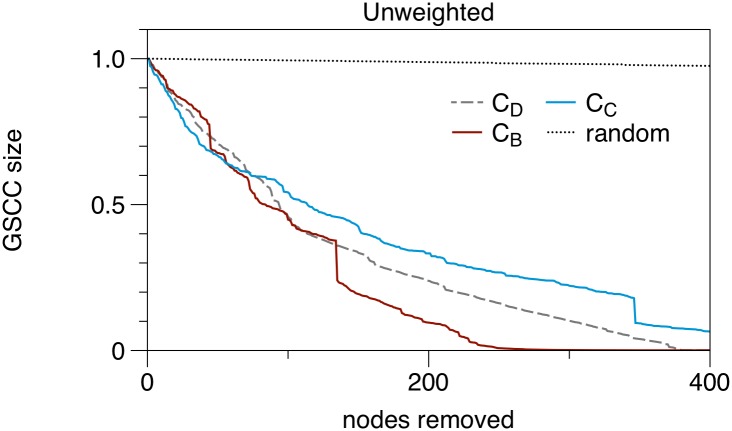
Impact of centrality based node removal, when up to 1% of the nodes are removed.CD-Degree centrality, CB-Betweenness, CC-Closeness. Size of giant strongly connected component is normalized to unity.